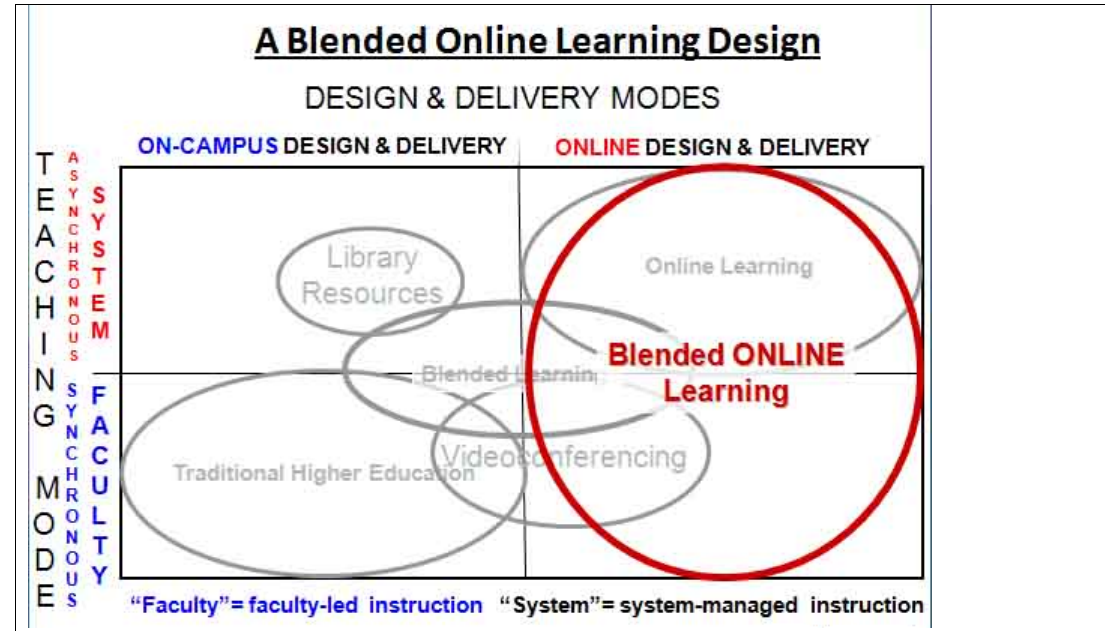
Figure 6 . The blended online learning design (BOLD)